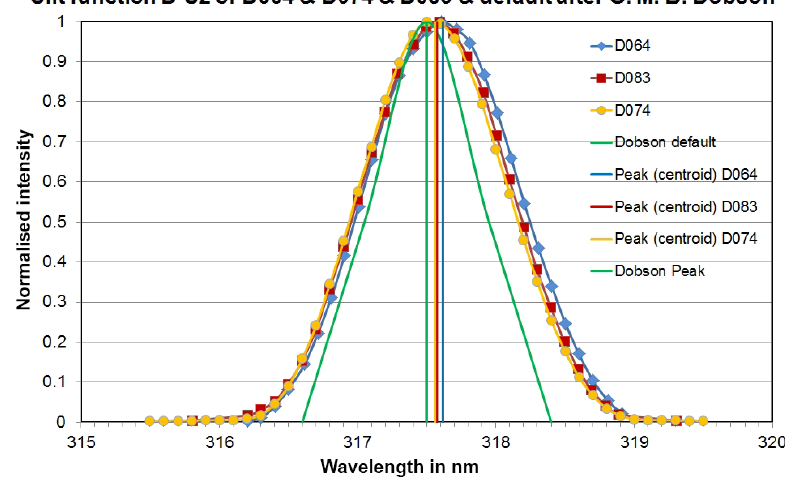
Figure 6. Slit functions at the short wavelength of wavelength pair D (D-S2) of all three reference